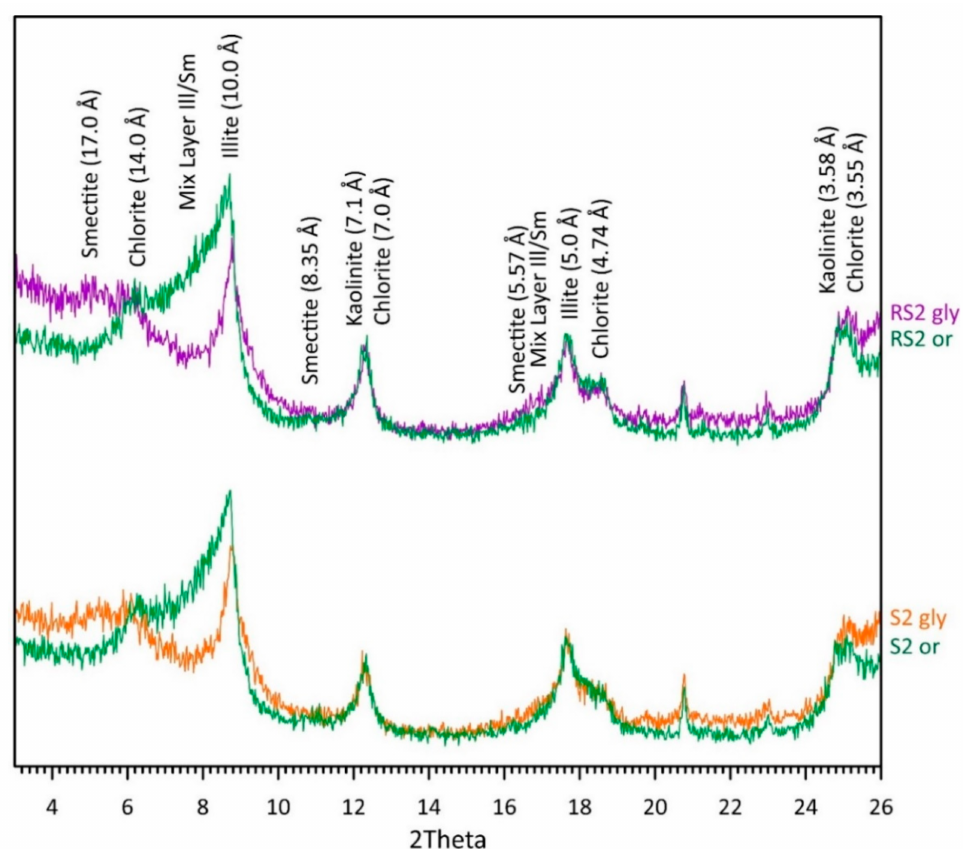
Figure 5. XRD patterns of glycolated and oriented sample RS2 ( top ) and glycolated and oriented sample S2 ( bottom ). The uppercase letters describe the clay mineral composition of samples RS2 and